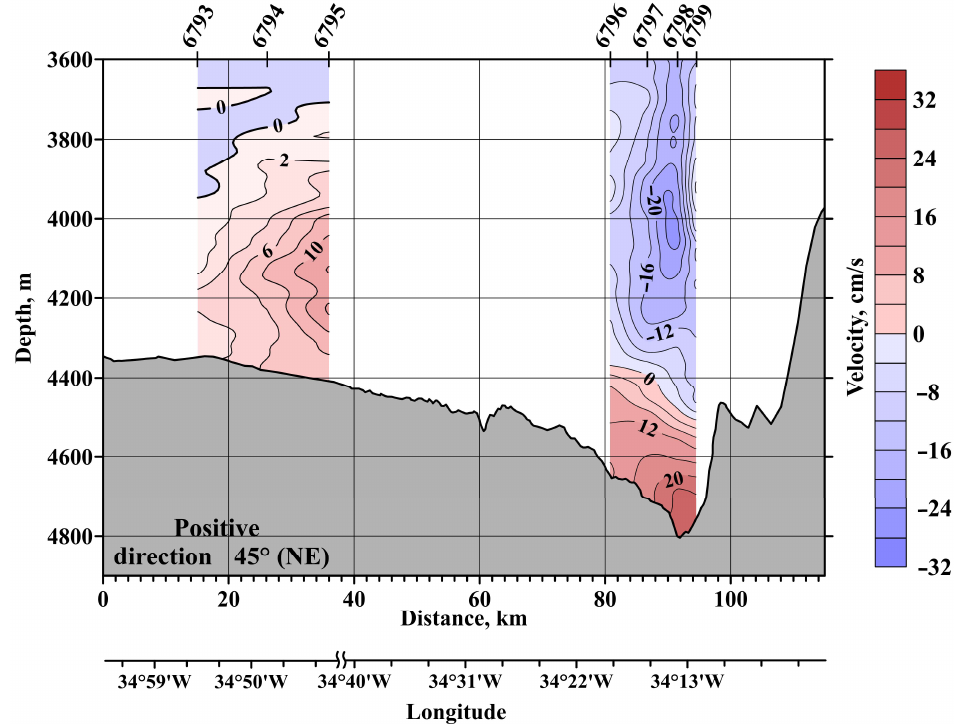
Figure 3. Distributions of velocity normal to the sections at 26°25′ S, 34°50′ W (western) and 26°40′ S, 34°15′ W (eastern) (see red dots in Figure 4) in April 2020. Numbers of stations are shown along the top axis [12].